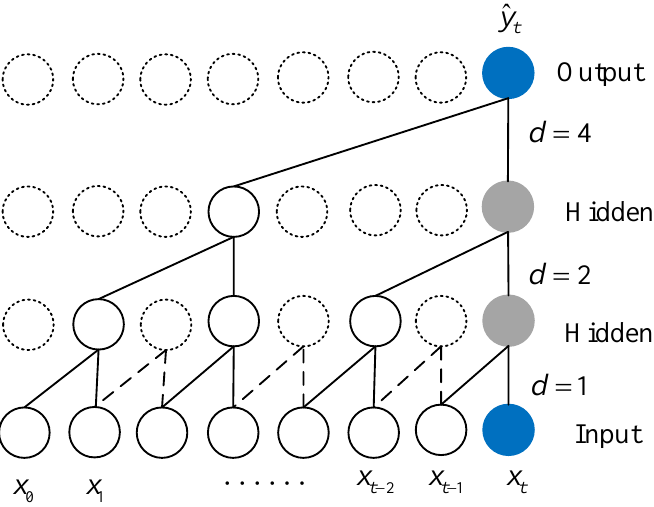
Figure 3. Structure of dilated causal convolutions.